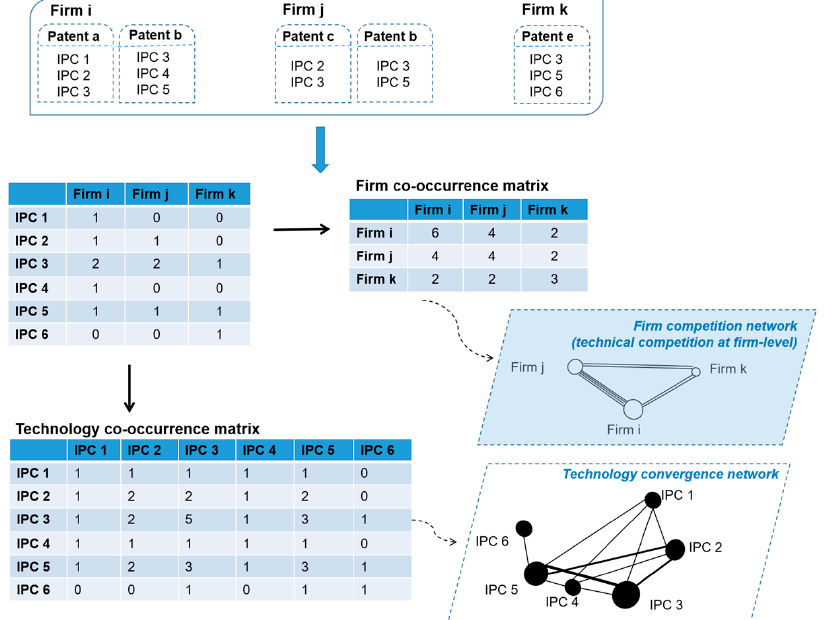
Figure 4. Construction of a firm’s competition network.